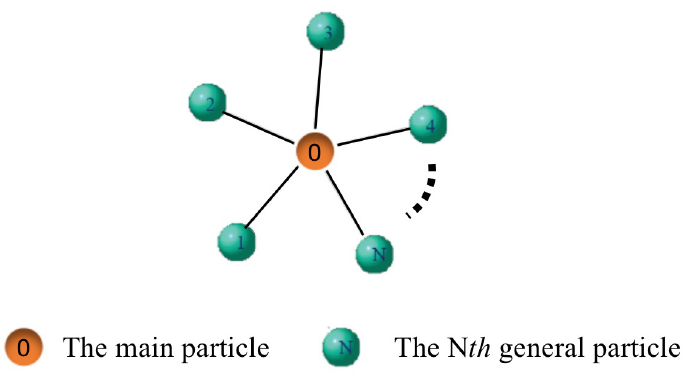
Figure 1. Structure model of the